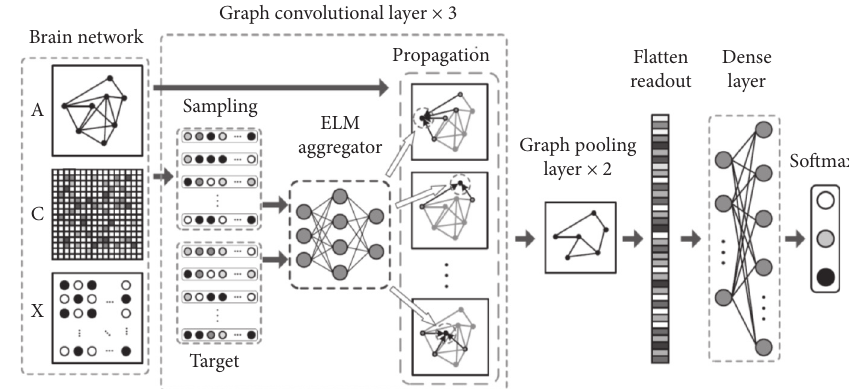
Figure 3: Architecture of GNEA for brain network